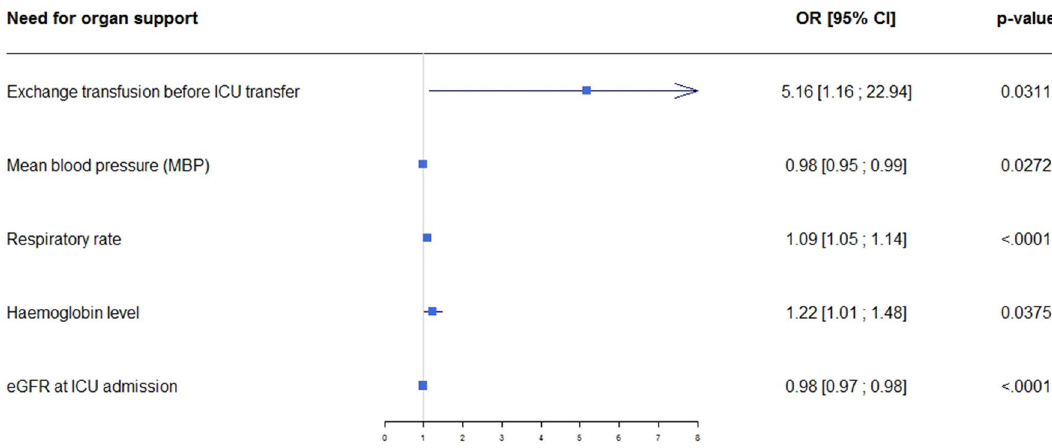
Figure 2. Forest plot of factors associated with adverse outcomes by multivariable